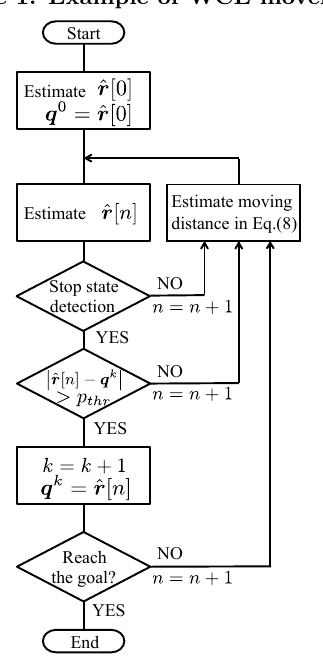
Figure 2: Flowchart of moving distance